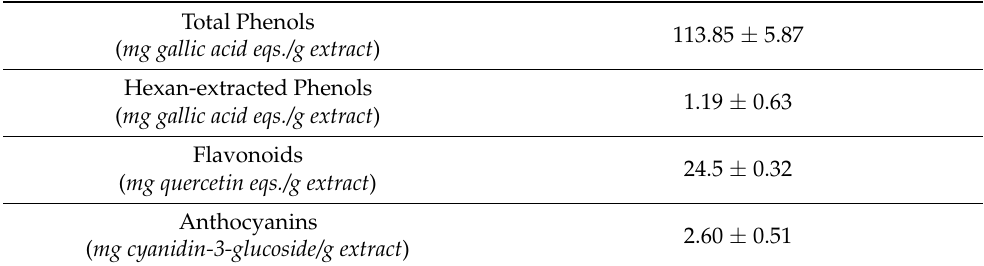
Table 1. Phenol, flavonoid and anthocyanin content of lignin fraction extracted from egagropili. Total